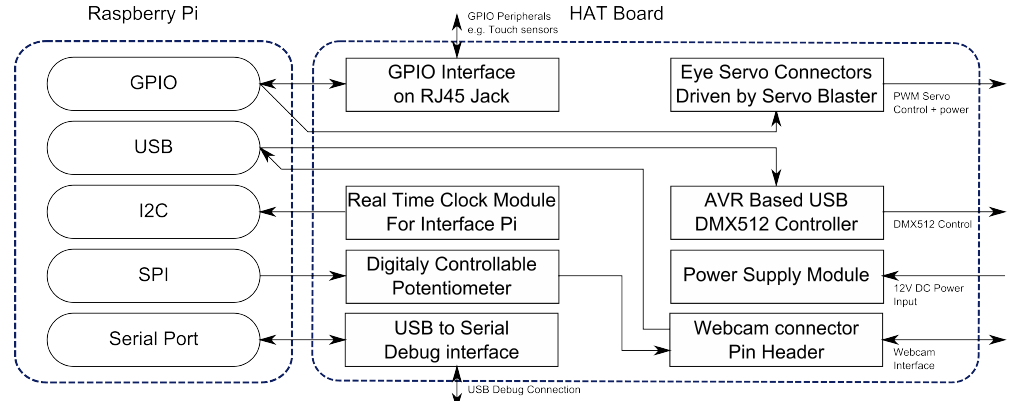
Figure 11. Block Diagram of Erica